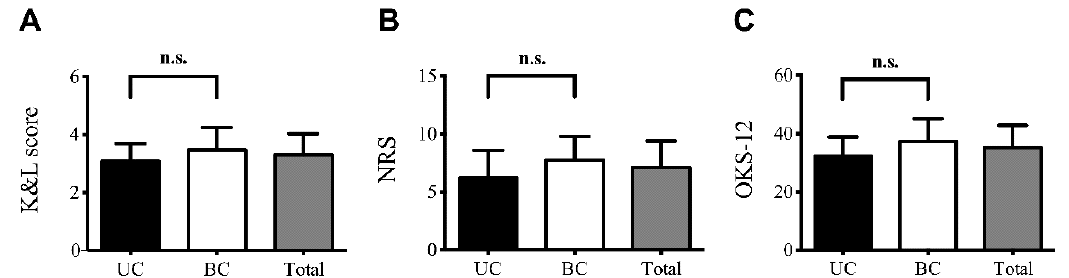
Figure 1. Clinical parameters of the study population. Mean (± SD) K&L, NRS and OKS-12 scores of the total study population (Total) and the patients diagnosed with UC or BC OA are presented. Comparing UC OA with BC OA no significant differences in ( A ) the severity of OA (K&L score), ( B ) knee pain (NRS) and ( C ) function (OKS-12) were observed. Unpaired student’s t -test was used for statistical analysis. Data are expressed as mean ± SD.